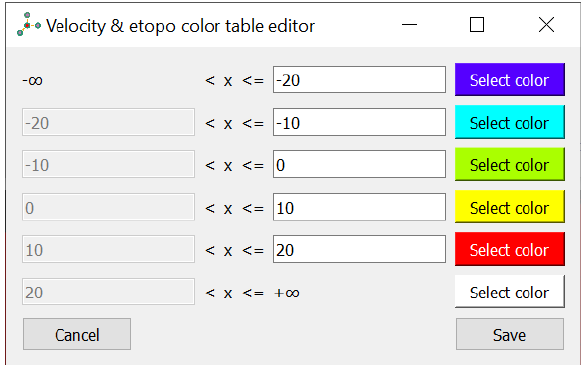
Figure 1: Building a colour table.